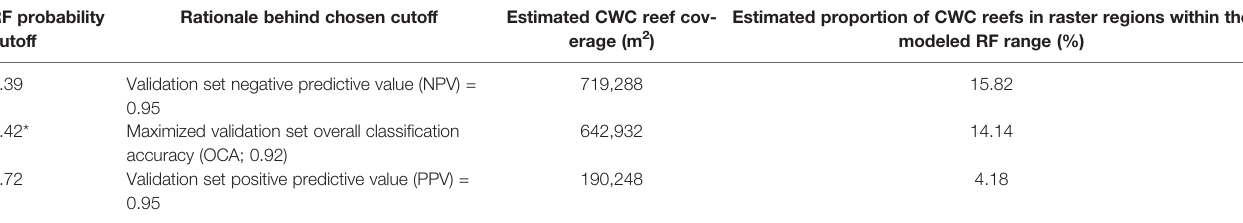
TABLE 7 | Tautra Ridge cold-water coral (CWC) reef coverage estimated by the random forest (RF) prediction model at three different probability cutoffs. RF probability cutoff